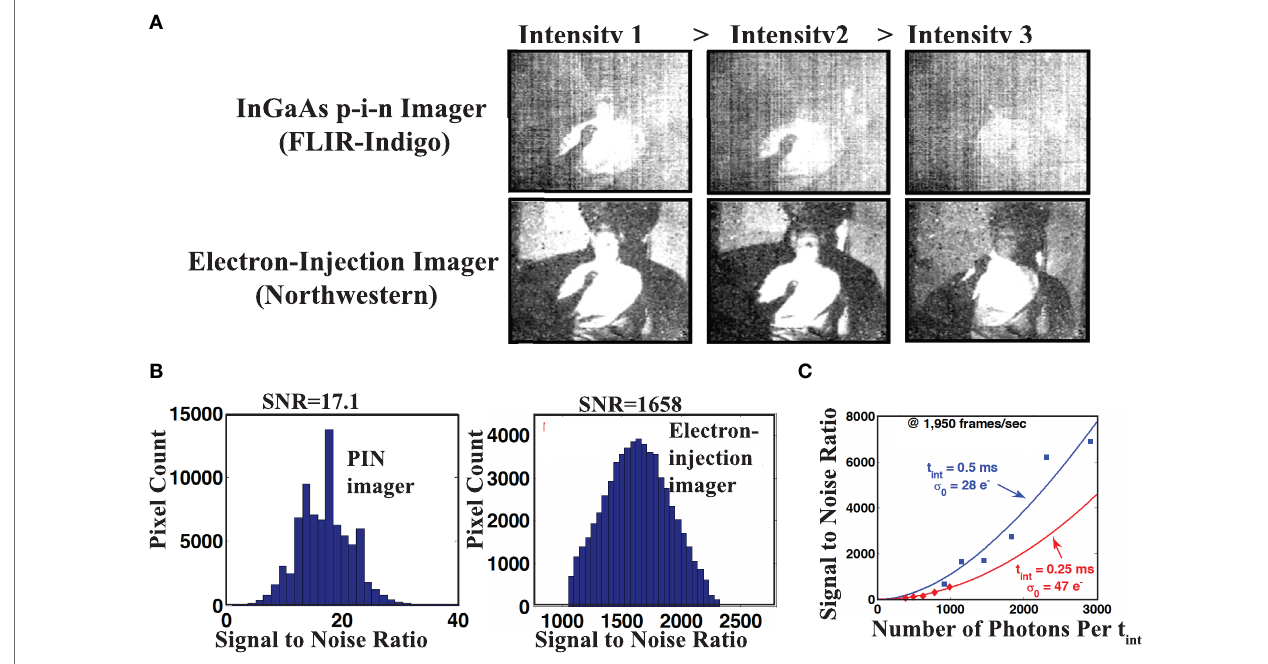
FiGURe 8 | (A) Comparison images of a commercial camera (AlphaNIR, from FLIR) and the first-generation electron-injection imager. Both cameras are cooled, coupled with f/1.8 lens, and used at the same integration time of 0.5 ms. (B) The SNR histograms of the commercial AlphaNIR camera (left) and the first-generation electron-injection imager (center), acquired by imaging the same source at equal dynamic range. (C) The plot of the SNR versus the number of photons per integration time of the first-generation electron-injection imager. The data was fitted to the theoretical equation, and the noise parameters were extracted from the fit (Memis et al., 2010a).